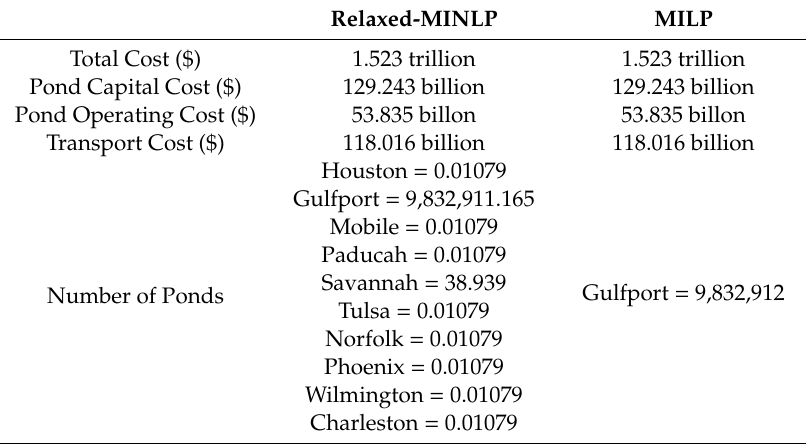
Table 12. Comparison of solution from relaxed-MINLP and MILP solvers: CONOPT 3 version 3.17 A and CPLEX version 12.6.3.0 for the U.S.